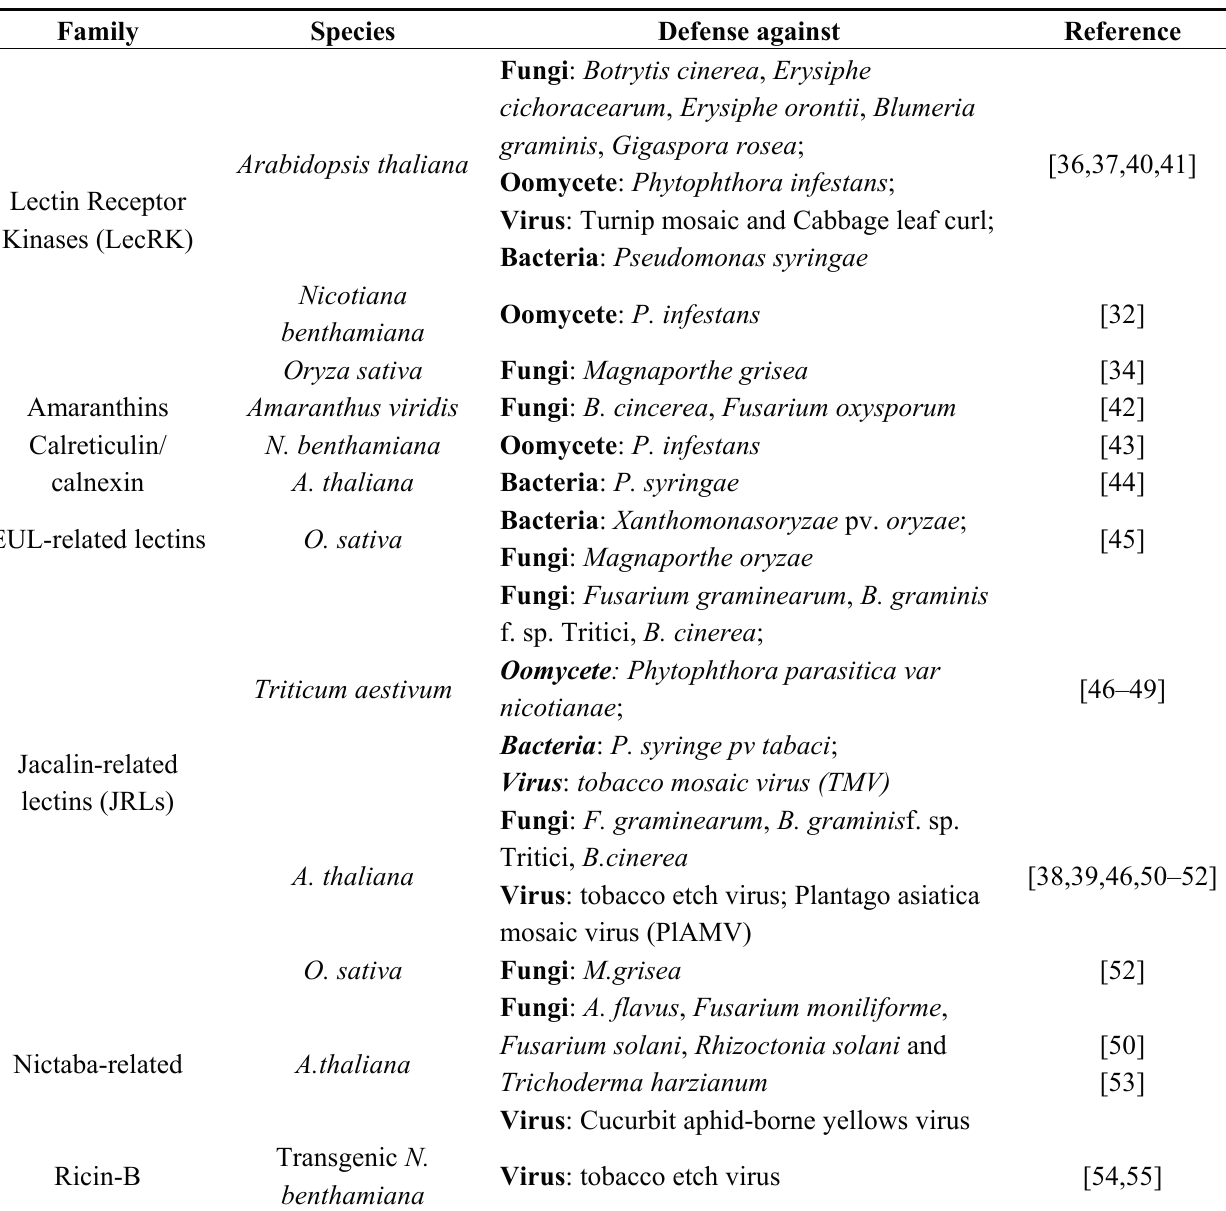
Table 1. Plant lectins showing antimicrobial